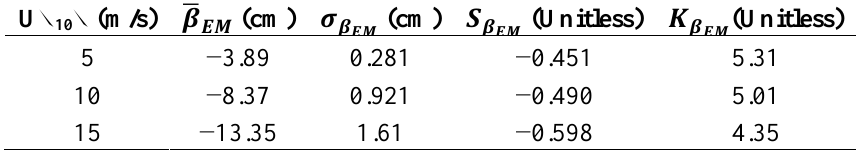
Table 1. EM bias time series main statistical descriptors for incidence/scattering θ wind direction φ = 45°, and U